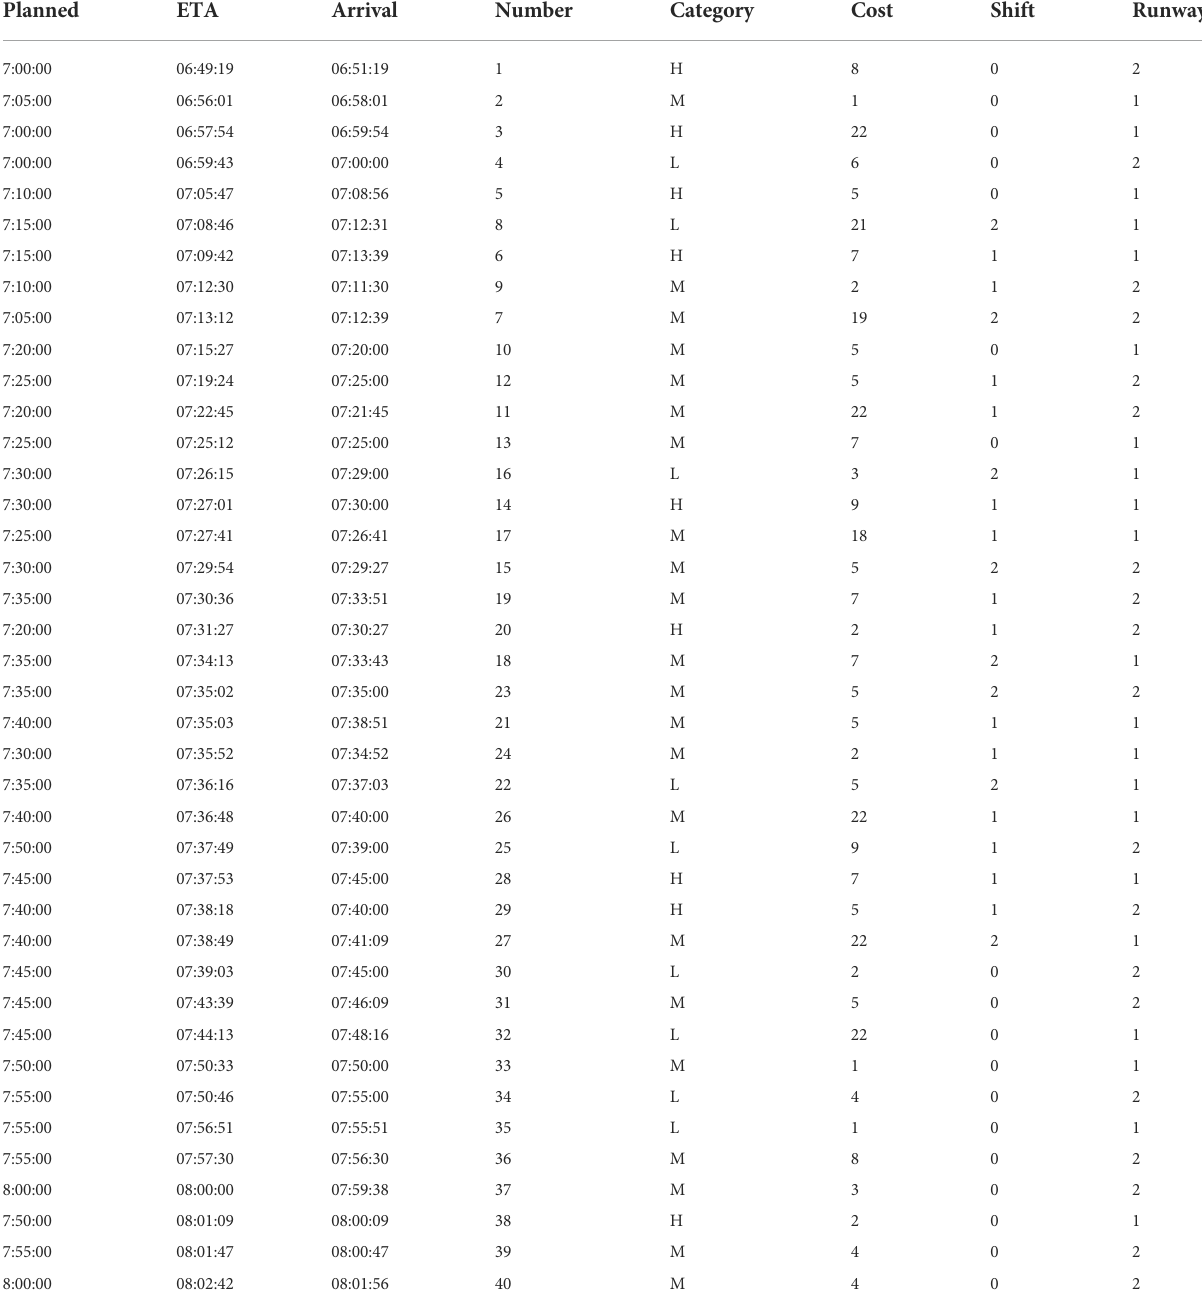
TABLE 3 Optimal schedule for Munich airport with N = 40 aircraft landing between 07:00:00 and 08:00:00 on K = 2 runways. Planned ETA Arrival Number Category Cost Shift